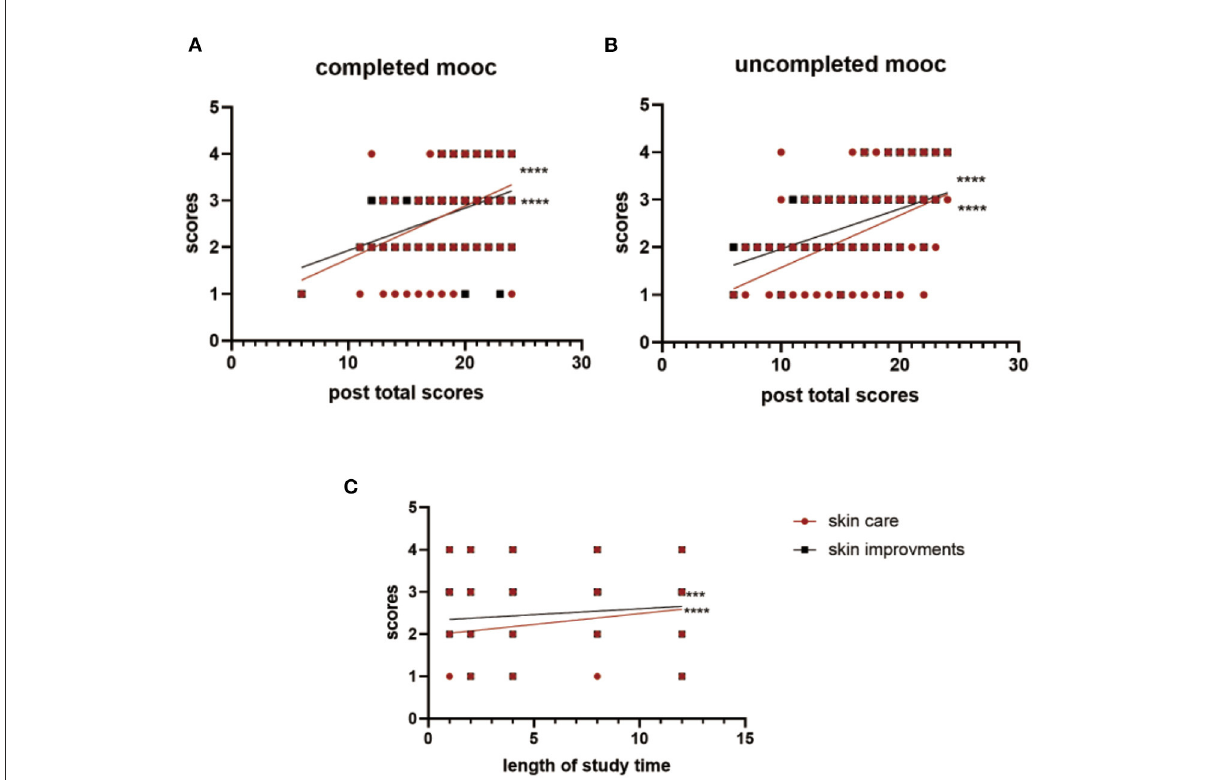
FIGURE2 (A) The Spearman correlation co-efficients of completed MOOC participants’ skin care practice changes and skin improvements correlated with their post total scores are 0.406 and 0.393 respectively, and the correlation co-efficient of the correlation between scores of skin care changes and skin improvements is 0.306 ( p = 0.000). (B) The Spearman correlation co-efficients of uncompleted MOOC participants’ skin care practice changes and skin improvements correlated with their post-total scores are 0.502 and 0.463 respectively, and the correlation co-efficient of the correlation between scores of skin care changes and skin improvements is 0.434 ( p = 0.000). (C) The Spearman correlation co-efficients of uncompleted MOOC participants’ skin care practice changes and skin improvements correlated with their length of study time are 0.258 and 0.202 respectively ( p = 0.000). ***: p = 0.0001. ****: p < 0.0001. MOOC, massive open online